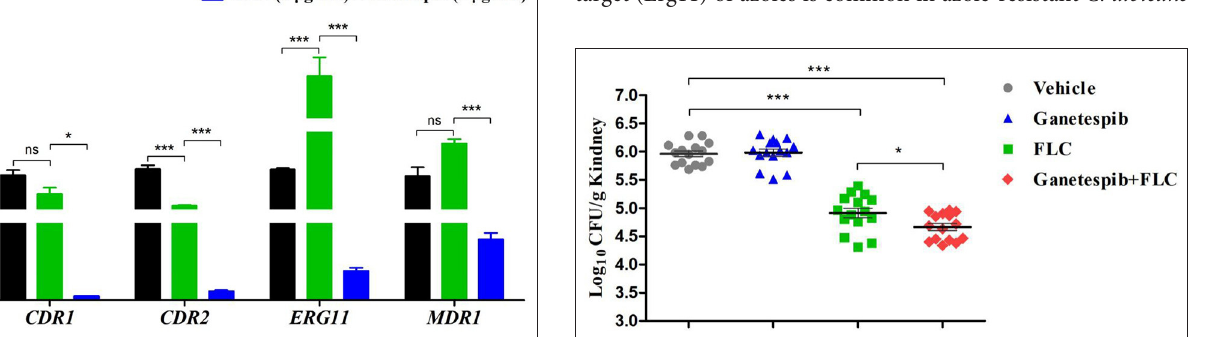
FIGURE 4 | Relative expression levels of azole resistance-related genes of C. albicans 0304103 after the treatment of ganetespib (* P < 0.05, *** P < 0.001, determined by Student’s t -test).